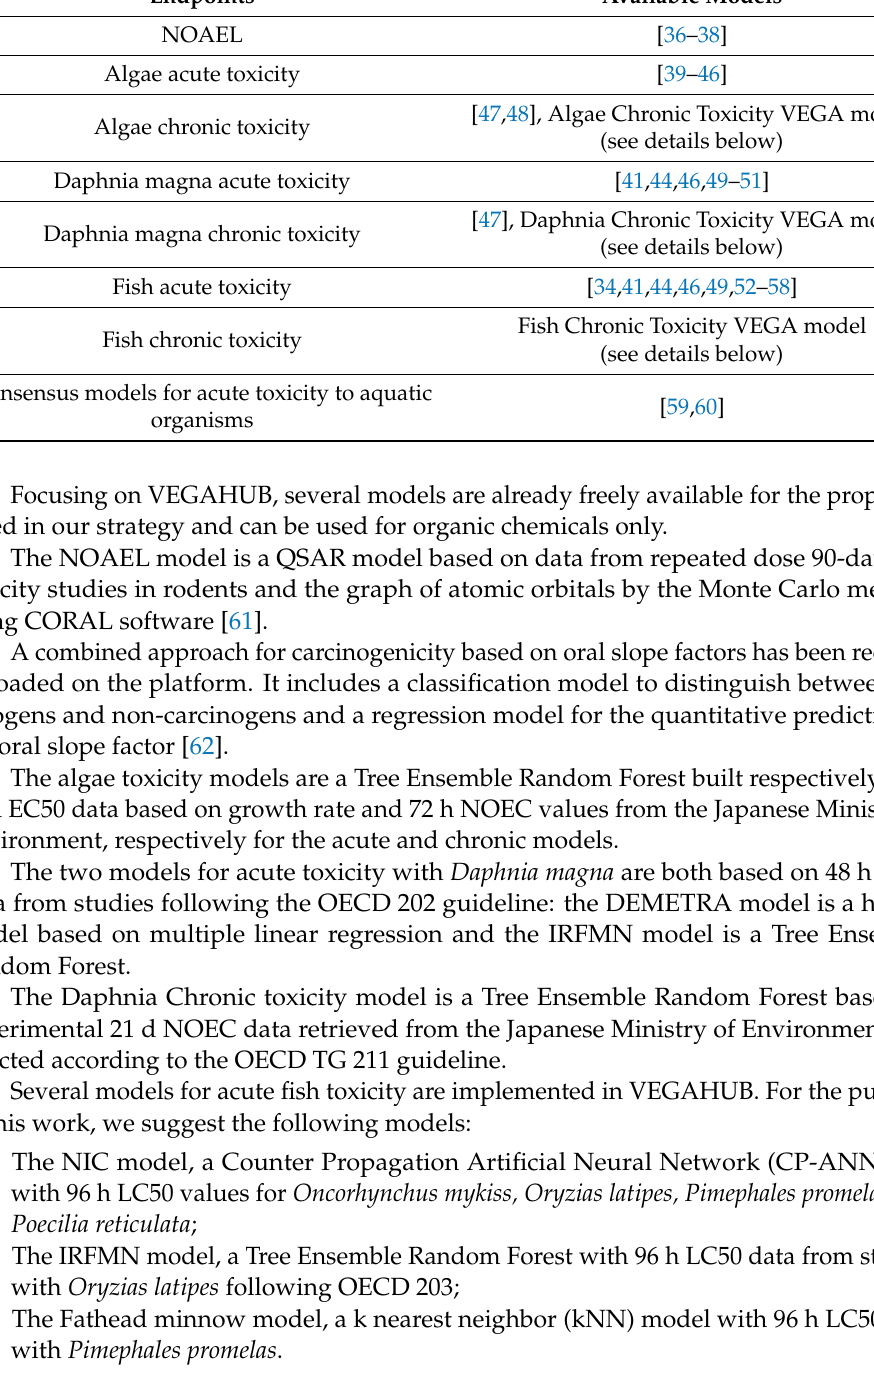
Table 5. Examples of models that can be used to predict the eco- and toxicological properties required for the proposed strategy. Endpoints Available